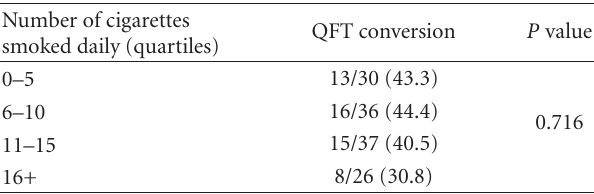
Table 2: QFT conversion (IFN- γ ≥ 0.70IU/mL) at 18 months by quartiles of number of cigarettes smoked among persons who inject drugs in Tijuana, Mexico, 2006–2008.